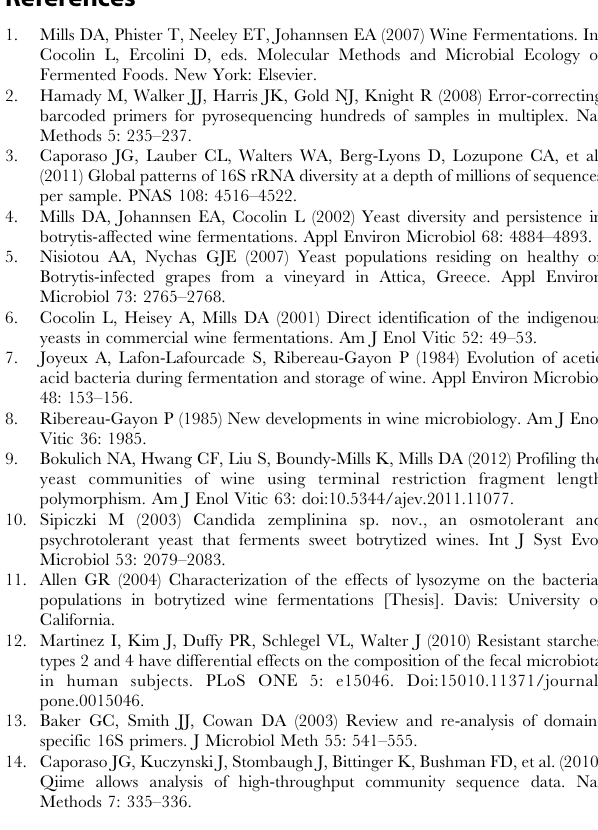
Figure S2 Taxonomic key for Figure 2. Table S1 V4 primers and barcodes used in this study. Table S2 V5 barcodes used in this study. Table S3 Sequencing Raw Read and Quality Filtration Statistics. Table S4 BAS genus-level taxonomy for V4 5 9 reads. Table S5 BAS genus-level taxonomy for V4 3 9 reads. Table S6 BAS genus-level taxonomy for V5 5 9 reads. Table S7 BAS genus-level taxonomy for V5 3 9